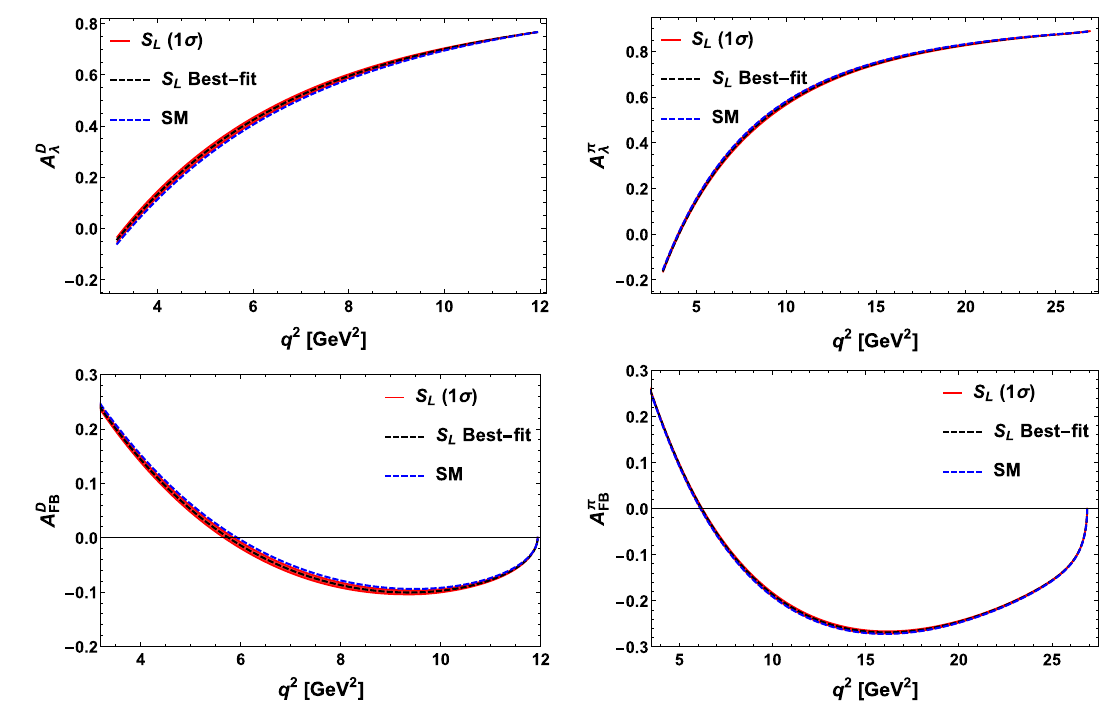
→ D + τ − ¯ ν τ (left panel) and ¯ B ∗ → π + τ ¯ ν τ (right d d